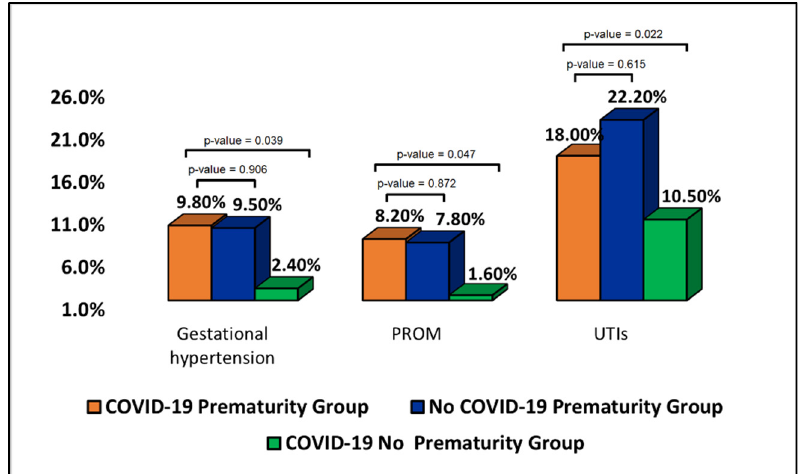
Figure 2. Proportions of patients with gestational hypertension, premature rupture of membranes, and urinary tract infections during previous pregnancies. and urinary tract infections during previous